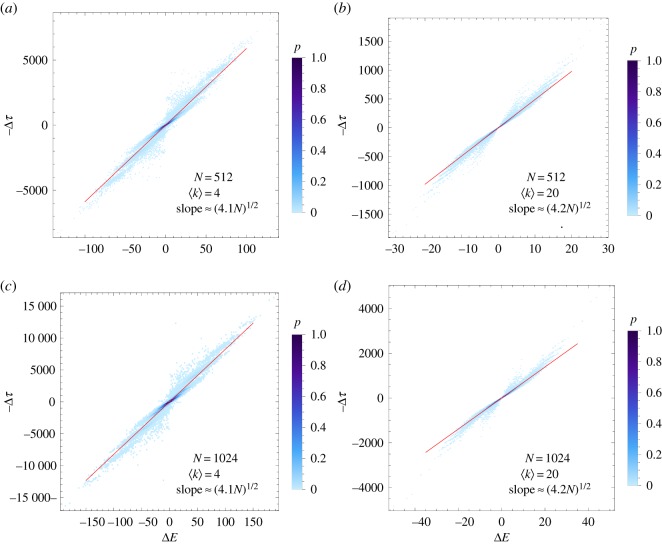
Asymmetry in the Barabási–Albert GENs ΔEij = Eij − Eji compared with the asymmetry in the MFPTs for those networks, Δτij = τij − τji. The figure labels are identical to those in figure 5, with a similar behaviour in scaling and variation from the best fit line.